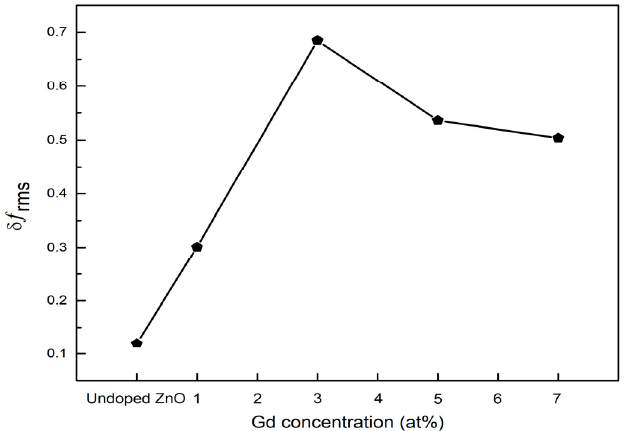
Figure 8. Root mean square values, δ f rms , of MFM images of undoped ZnO and Gd ‐ doped ZnO films. Table 3. The magnetic properties of undoped ZnO, (1, 3, 5, 7 at%) Gd ‐ doped ZnO, and 3 at% (Gd, Al) co ‐ doped ZnO films.